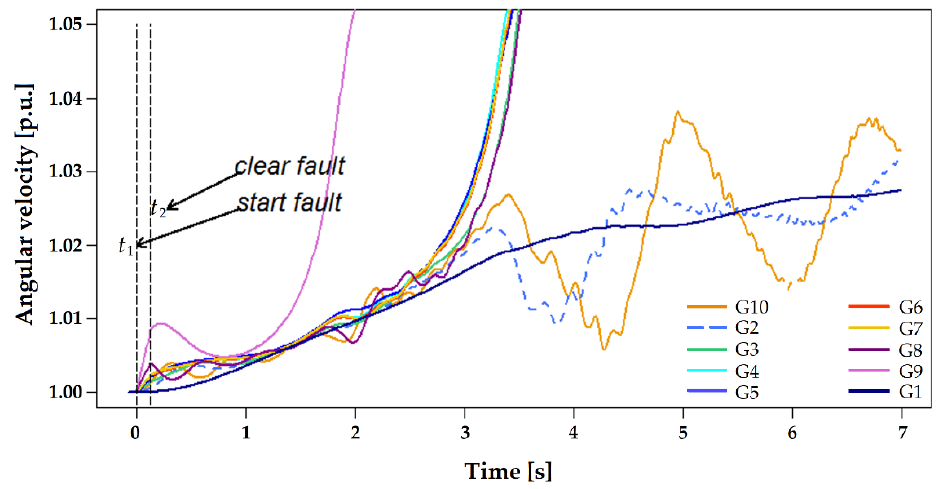
Figure 16. RACKE_SIS vs. time and without control.